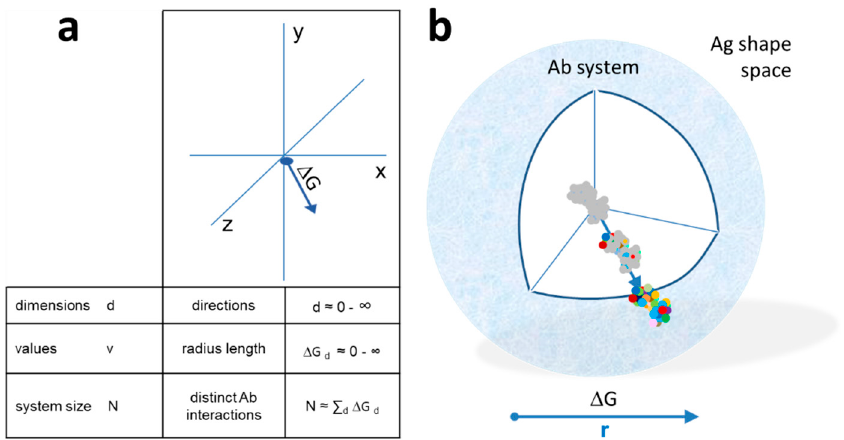
Figure 2. Quantitative interaction space and B-cell di ff erentiation. ( a ) The system of antibodies has a center as a reference point in a conceptual three-dimensional metric space of interactions. Structural diversity appears as directions (exemplary arrow) in Ag shape space. Distance is measured as the free energy change of antibody–antigen interaction. The total size of the system N is the sum of all interactions in all directions. ( b ) Diversity appears as we leave the center of the system, spherical shells representing various levels of resolution of molecular recognition. Colors represent distinct amino acids of antibody-binding site engaging in noncovalent bonding with the target molecule. Higher energy interactions engage more residues.